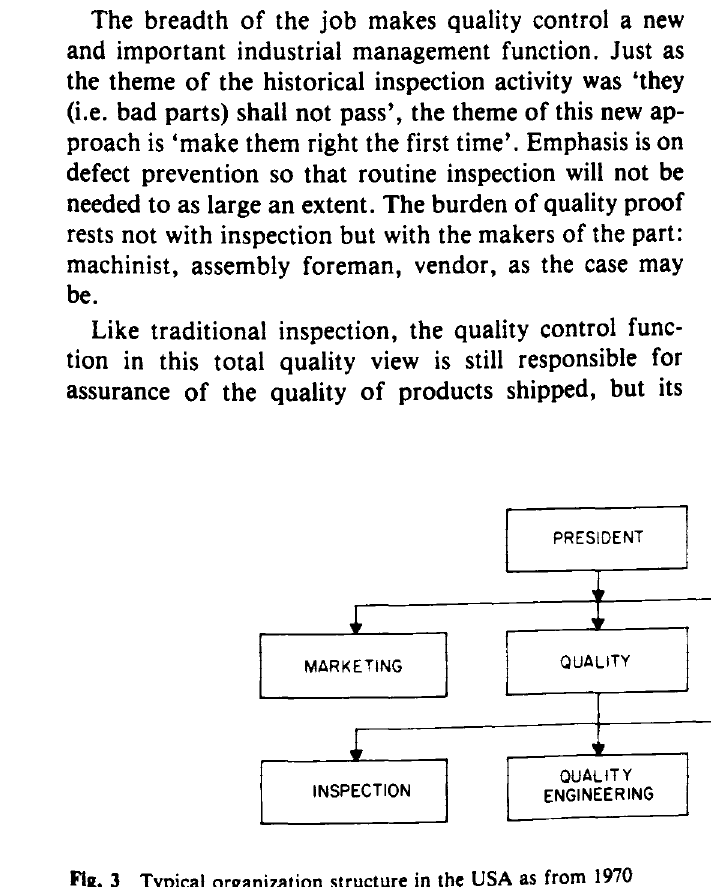
Fig. 3 Typical organization structure in the USA as from